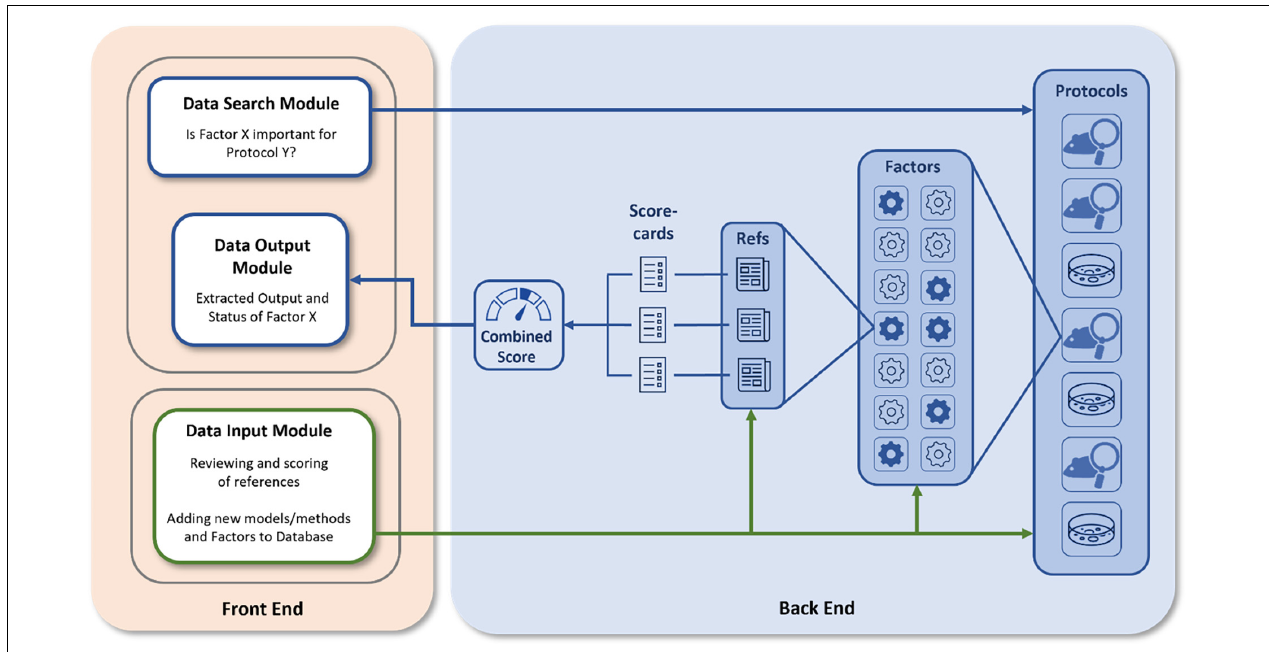
FIGURE 2 | PEERS platform structure. Users can interact with the PEERS platform (blue arrows) by searching for or adding information (Front End Modules). The PEERS database (Back End) consists of various protocols, for which generic and specific factors and related references have been identified. The Quality of Evidence for the importance of certain factors is evaluated using scorecards and a summary is presented by visualizing results in the user interface. Users can contribute by adding new protocols or factors and by scoring relevant references (green arrows).